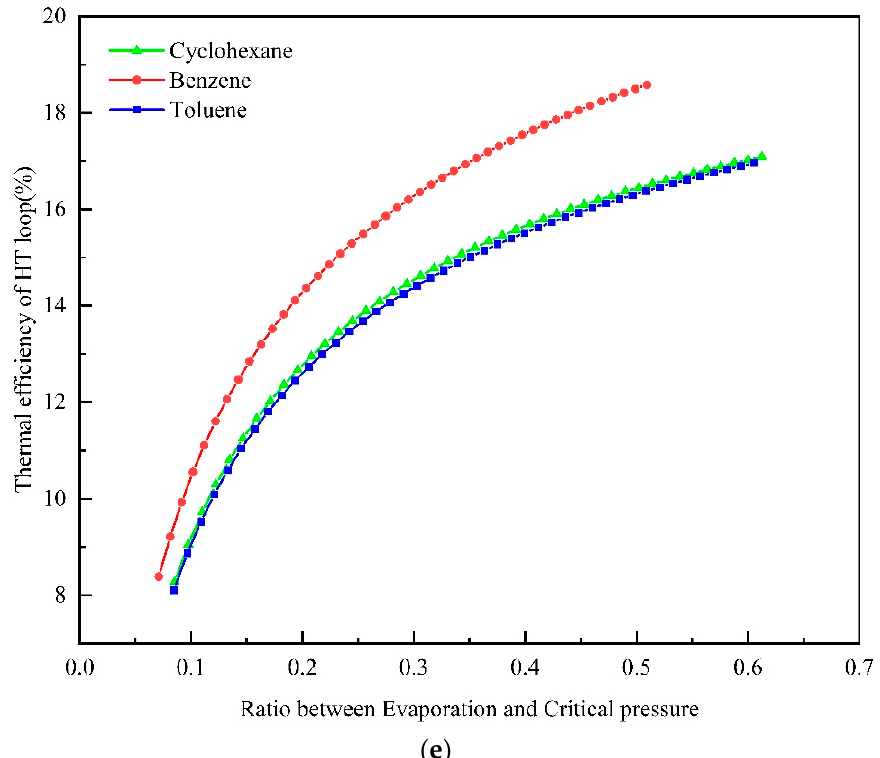
Figure 11. Thermodynamic parameters of the HT-loop ORC system. ( a ) this is the variation of the EG outlet temperature with the RECP of the HT loop. ( b ) this is the variation of the heat of condensation with the RECP of the HT loop. ( c ) this is the variation of the back work ratio as the RECP increases. ( d ) this is the trend in the net power increasing and decreasing with RECP. ( e ) this is the variation of the thermal efficiency with the RECP of the HT loop.